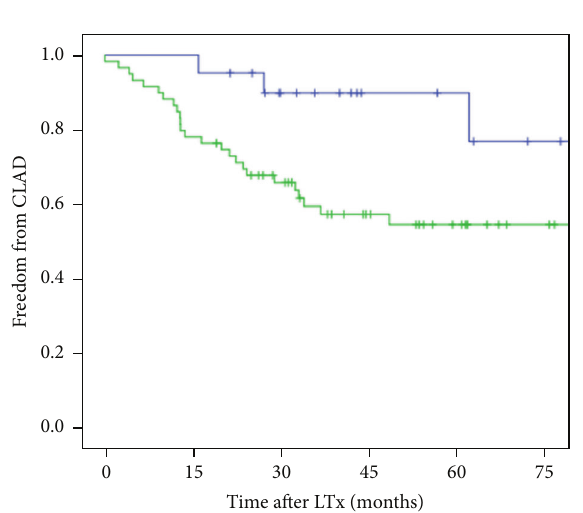
Figure 2: Freedom from CLAD in LTx recipients according to the presence of homozygous HLA-E ∗ 01:01 (in blue) compared to HLA- E ∗ 01:03 alleles (in green) (log-rank test, 𝑝 = 0.02 ).